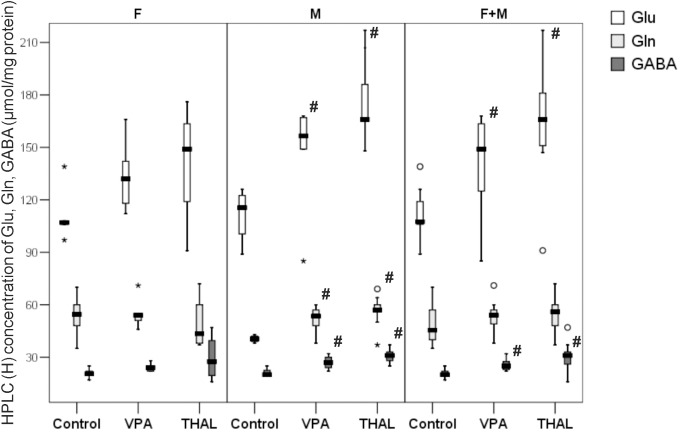
Box and Whiskers plot of total Glu, Gln, and GABA concentration in rat hippocampus homogenates measured using HPLC method. Results are presented as median (min-max) values of tested amino acids concentration. Differences statistically significant vs. control are represented by # p < 0.05. Number of rat pups: n = 10 (control), n = 11 (VPA) and n = 13 (THAL); # represents results statistically significant vs. control, p < 0.05, one-way ANOVA followed by Dunn’s correction; box containing 50% of results that fell in the range between 25% (bottom line) and 75% (top line), () median value,  – outlier point per rat, ∗ – extreme outlier point per rat.